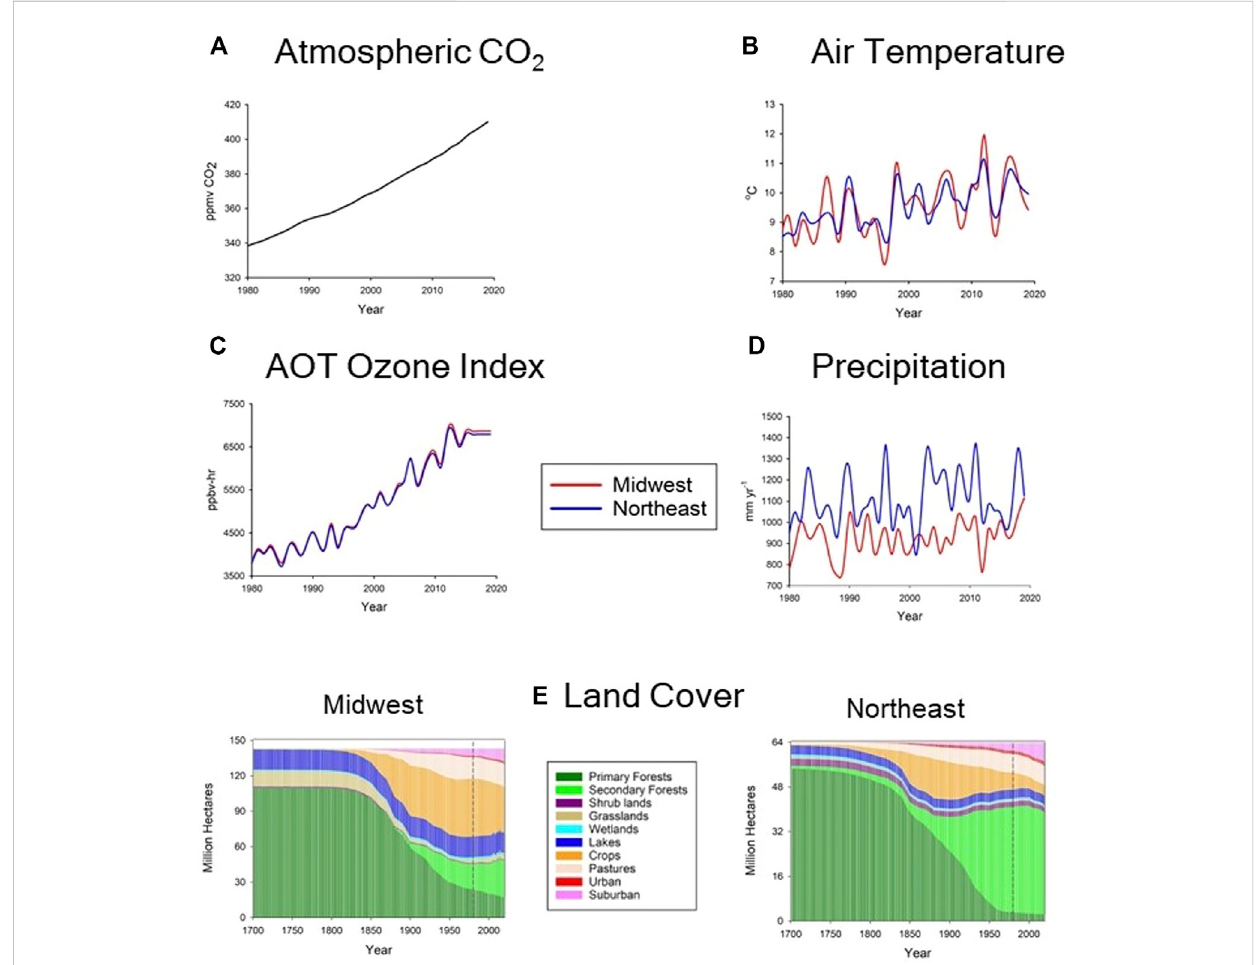
FIGURE 5 Examples of key land use management and other exogenous input variables driving forest carbon dynamics, as used in the Terrestrial Ecosystem Model.Carbonsequestrationestimatesdependontheseinputswithtimehorizonsthatre fl ectlong-term landuselegacyeffectsaswellasdecadal-scale impacts of key atmospheric drivers. NBI-based sequestration also varies spatially with these variables. It is the interactions across this complex amalgam of factors that determines the overall biotic response and cannot be predicted a priori . The long-term carbon sequestration estimates